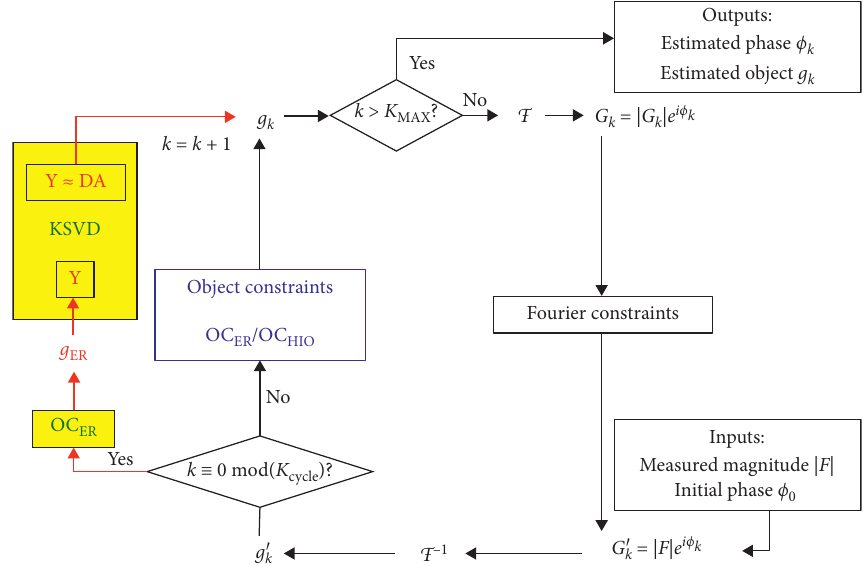
Figure 6: Illustration of the process to perform the ER +KSVD and HIO +KSVD by using different activations ( OC constraints, as depicted in the blue block. The yellow block diagram is the core of our proposed method which combines KSVD with the classical PR algorithms to render finer features of the object for the next PR iteration. The parameters K the maximum number of PR iterations, k th iteration, and iteration cycle for executing KSVD, respectively.